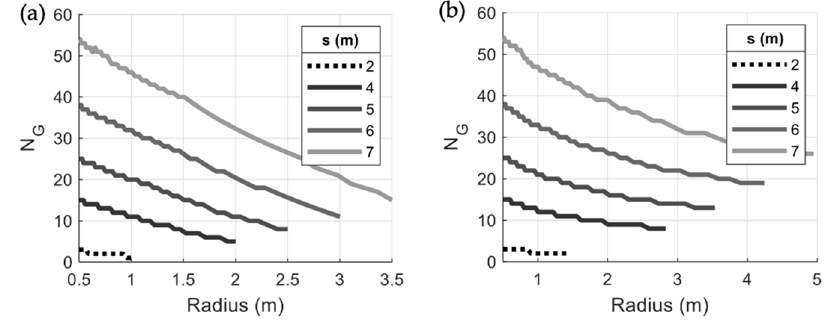
Figure 15. N G for each point of the soil section for ( a ) θ = 0° and ( b ) θ = 45°.